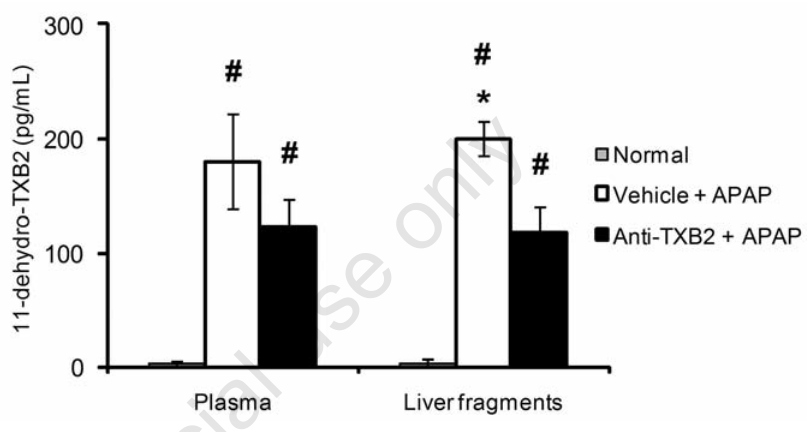
Figure 6. Effect of anti-TXB on TXB production by the plasma and liver fragments. 2 2 Anti-TXB (40 m g/kg, i.p.) and vehicle were given 3 h before APAP administration (150 2 mg/kg). Plasma and liver samples were taken 6 h after APAP administration. Concentration of TXB was determined in plasma and supernatants obtained after 1 h 2 incubation of liver fragments. Results represent mean±SEM of 6 mice per group. #